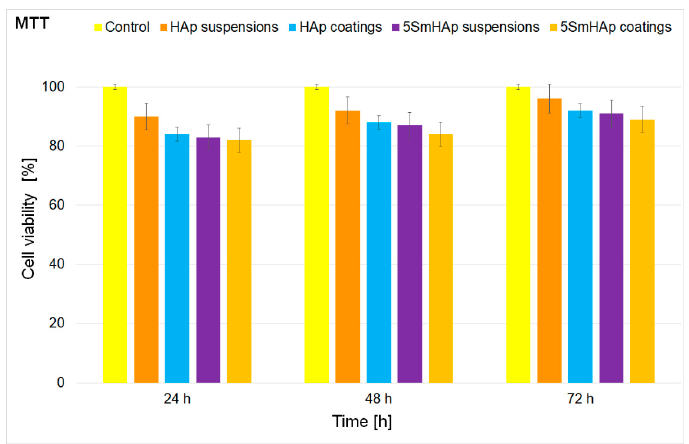
Figure 18. MTT assay for the viability of HeLa cells incubated with HAp and 5SmHAp suspensions and coatings at different time intervals.